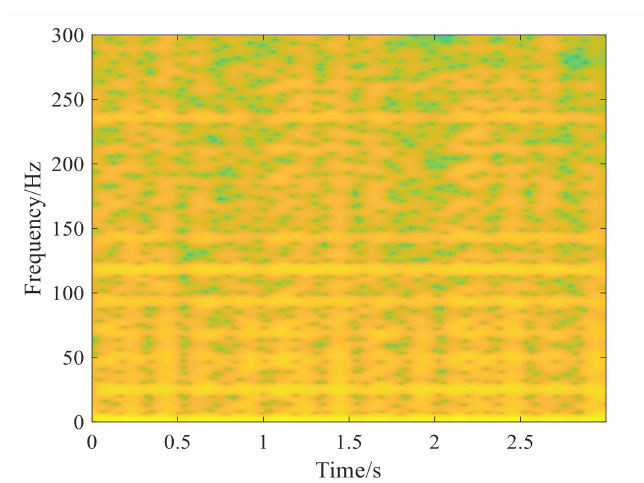
Figure 10. The TFR generated by